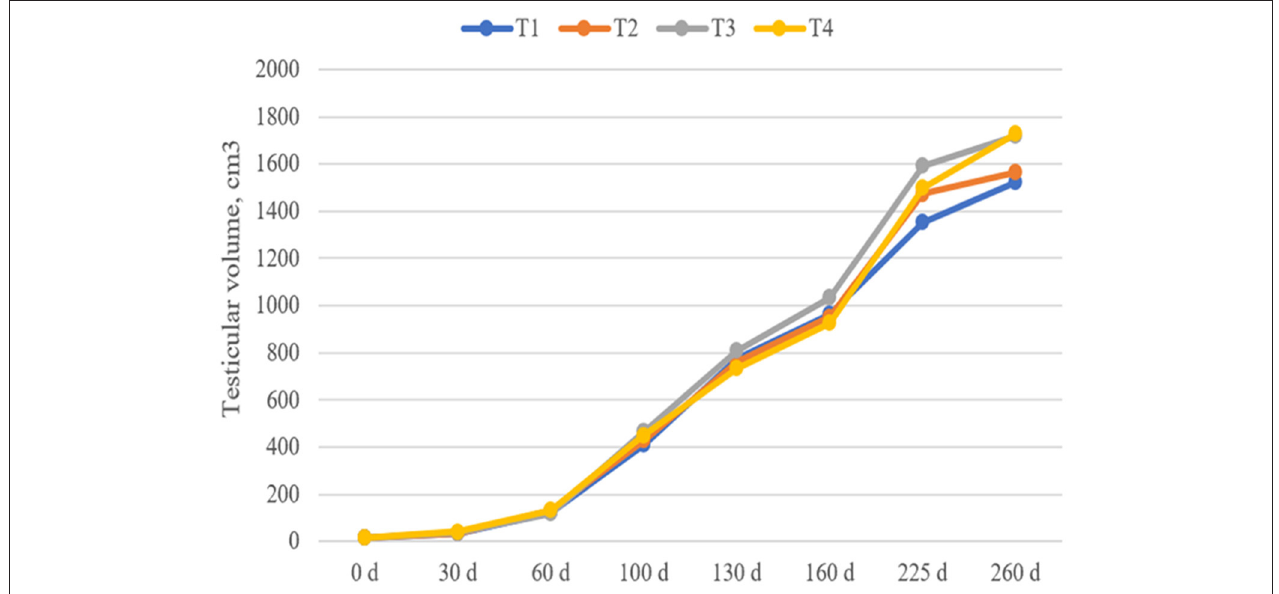
FIGURE 1 | Effect of dietary fiber and metabolites on boar testicle volume. T1, basal diet; T2, T3, basal diet supplemented with different dietary fiber level; T4, basal diet supplemented with probiotics and butyrate. Values are means and SEMs, n = 15 per group.